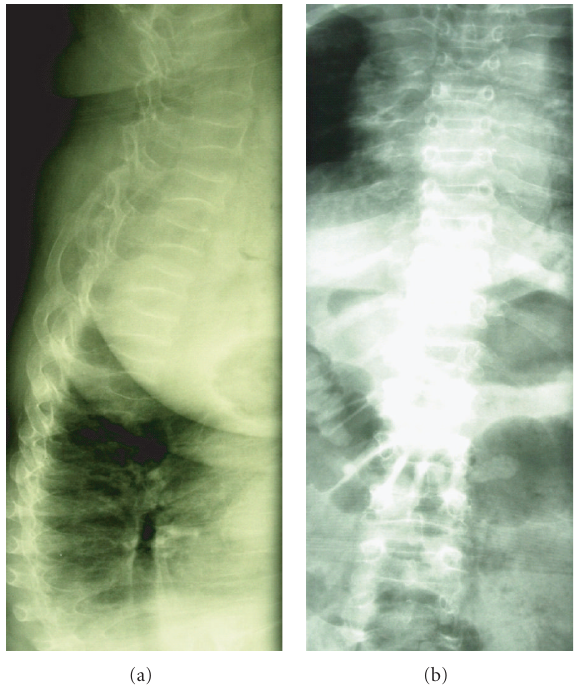
Figure 1: Multiple compressive vertebral fractures and rib fractures in a 22-year-old women diagnosed with JIA at 3 years of age. Bone densitometry (DXA, GE Prodigy): total femur BMD of 0,453g/cm 2 , T-score − 4,5; femur neck BMD of 0,536g/cm 2 , T-score − 4,2.